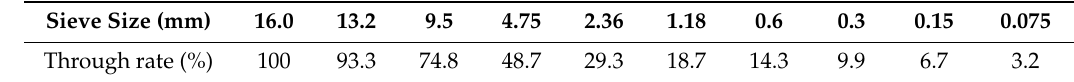
Table 9. Gradation of PAC-13 for